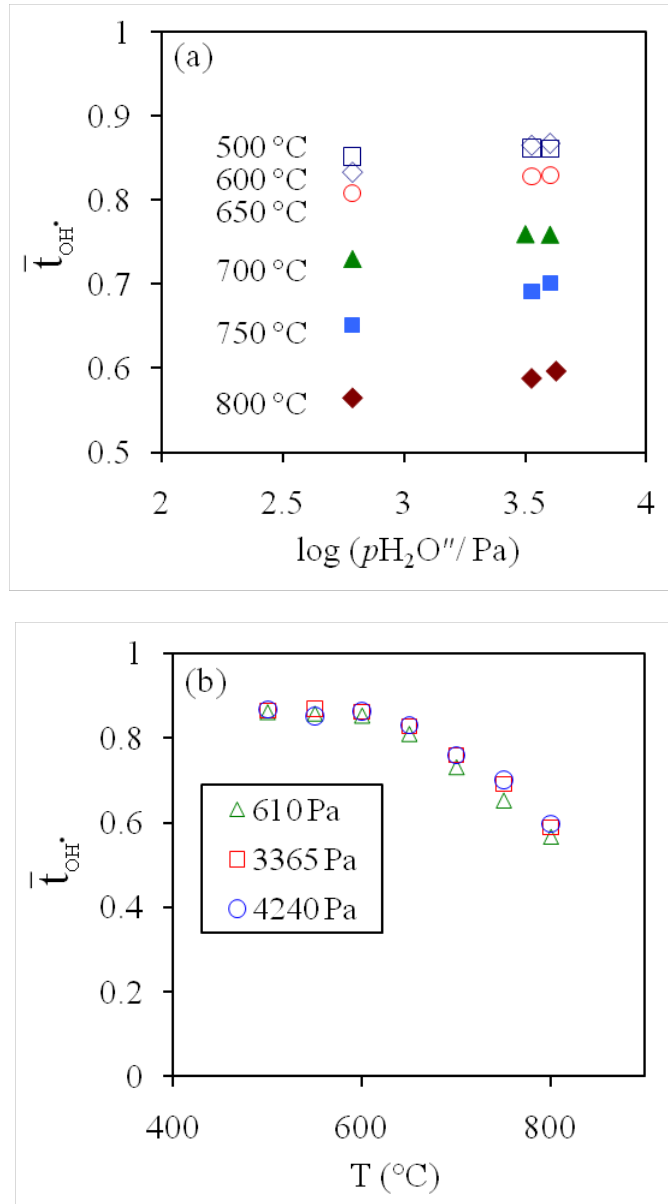
Figure 11. Effective proton transport number in the bulk SZY membrane exposed to p H 2 O gradient in air as a function of: ( a ) p H 2 O // ( p H 2 O / = 40 Pa) and ( b ) temperature.